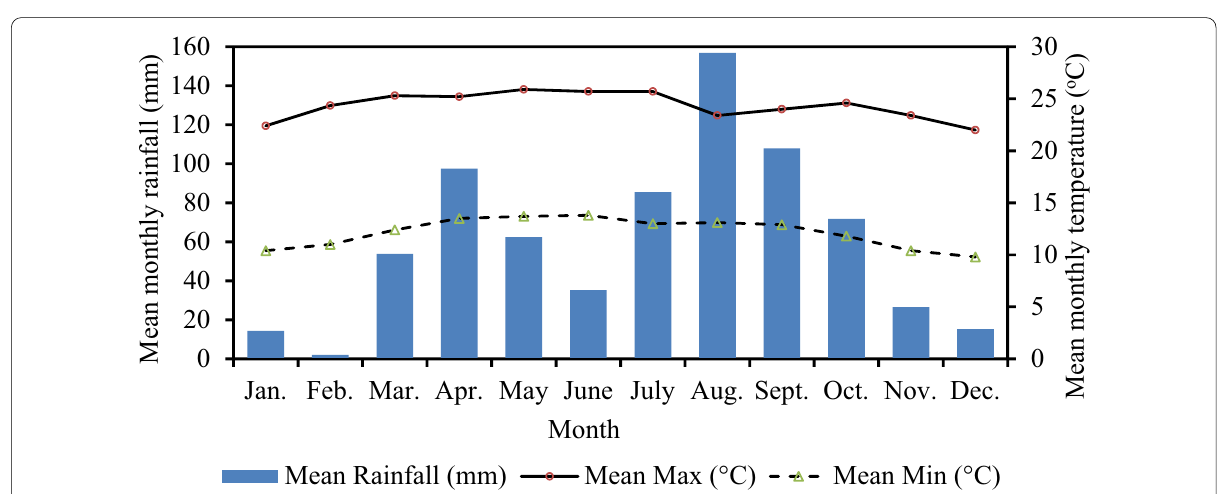
Fig. 2 Mean monthly rainfall and mean monthly minimum and maximum temperatures of the study